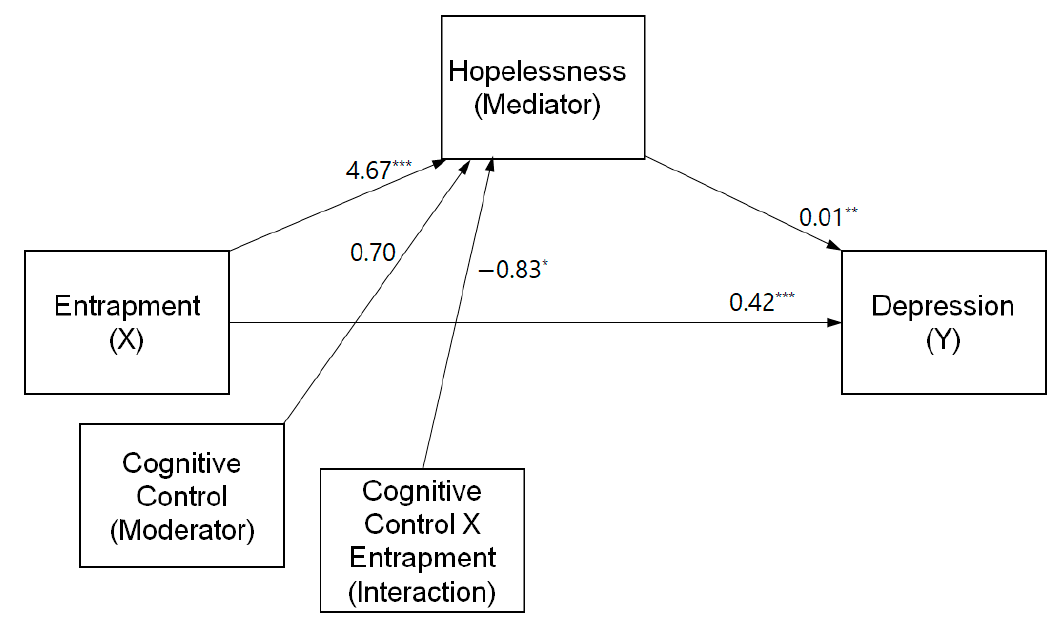
Figure 3. The fi nal model. * p < 0.05, ** p < 0.01, *** p < 0.001. Figure 3. The final model. * p < 0.05, ** p < 0.01, *** p <